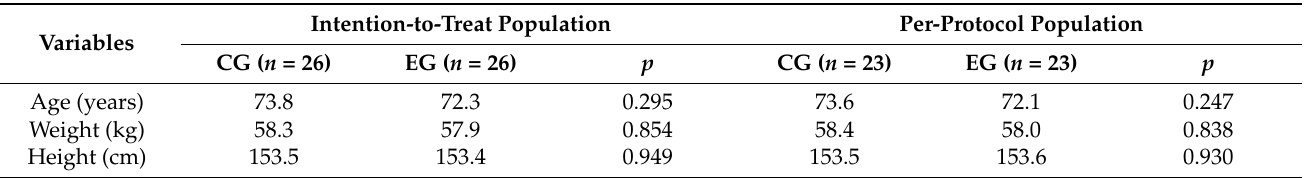
Table 2. Baseline demographic